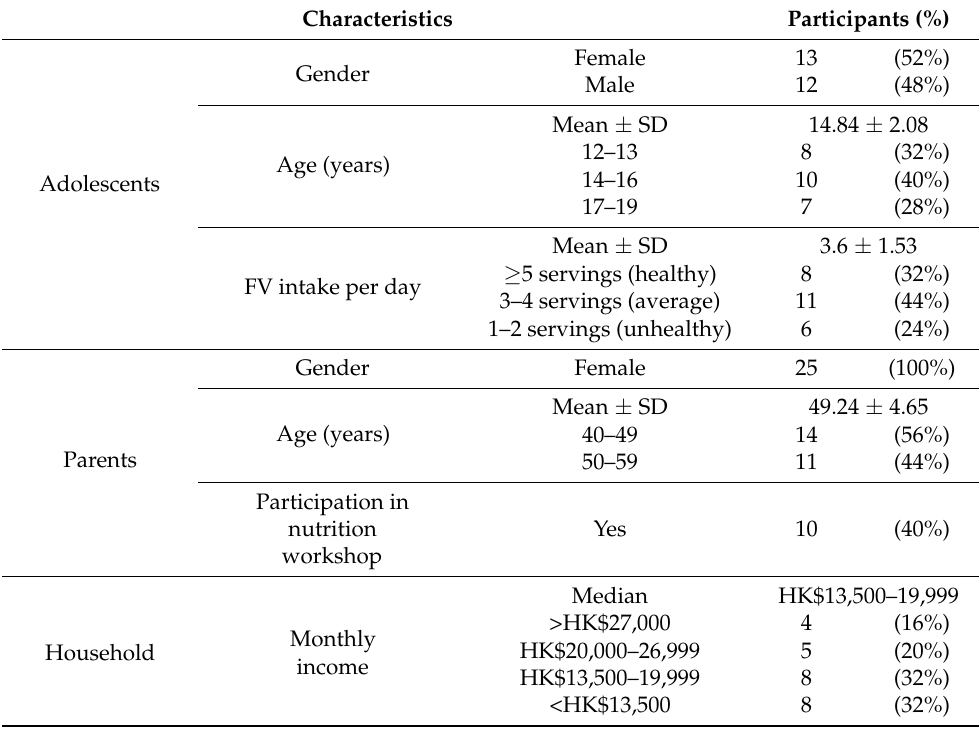
Table 1. Distribution of subject characteristics.